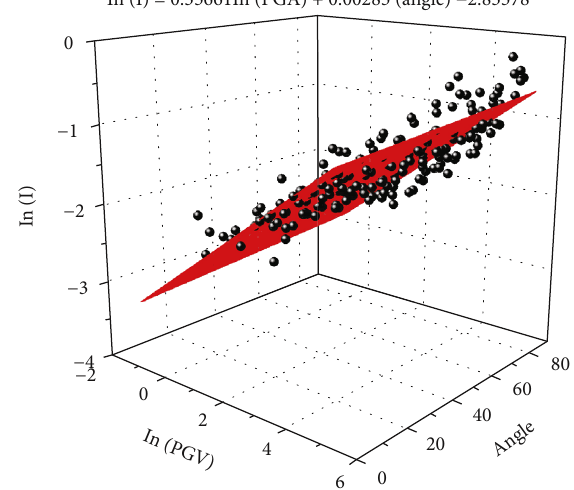
Figure 7: Three-dimensional relationship among velocity pulse, excitation angle, and bridge